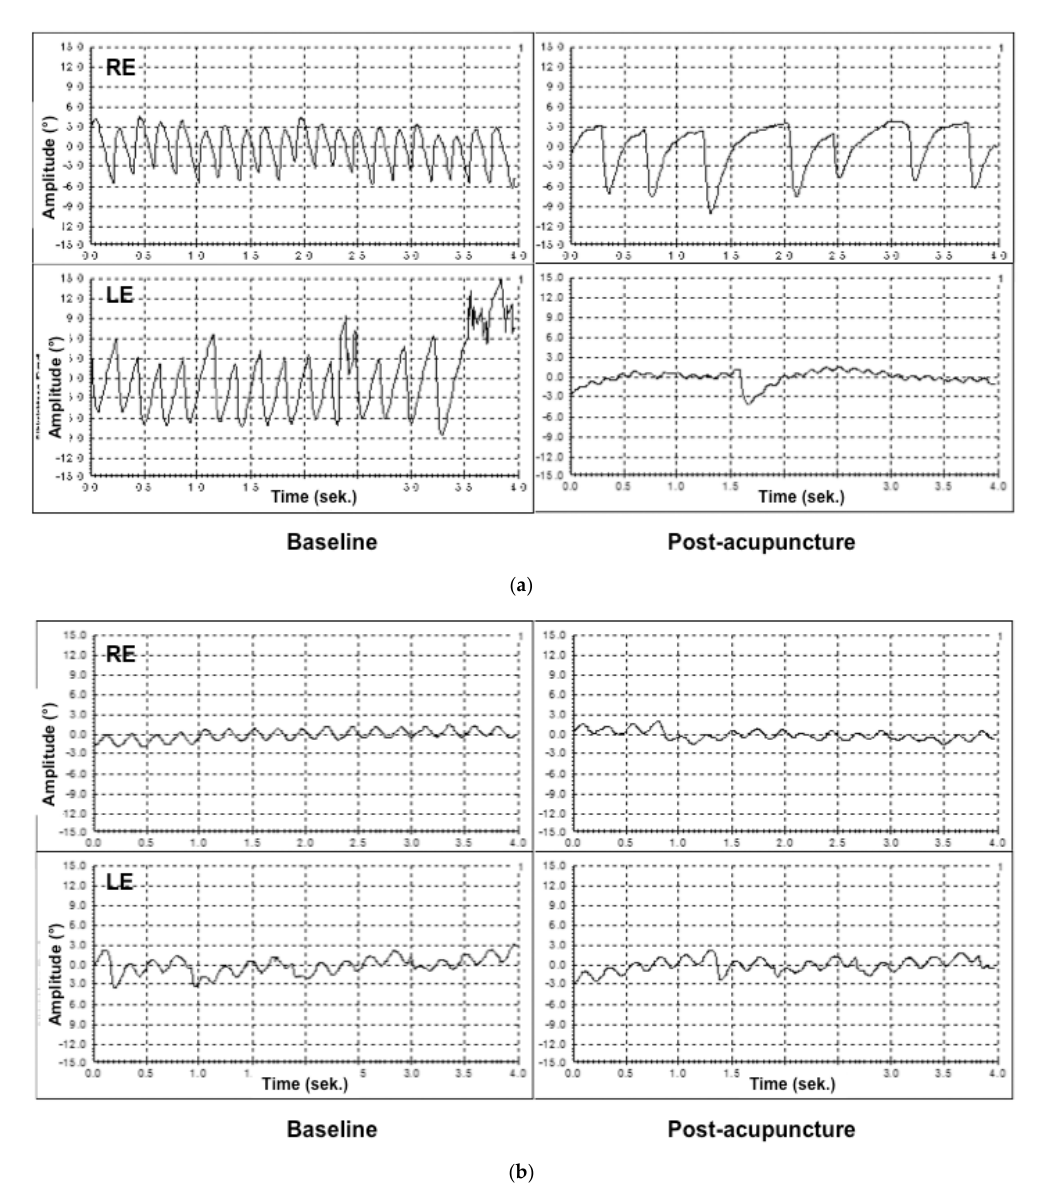
Figure 3. Nystagmography pictures in two patients ( a ); ( b ) baseline and following acupuncture treatment, as described bellow: